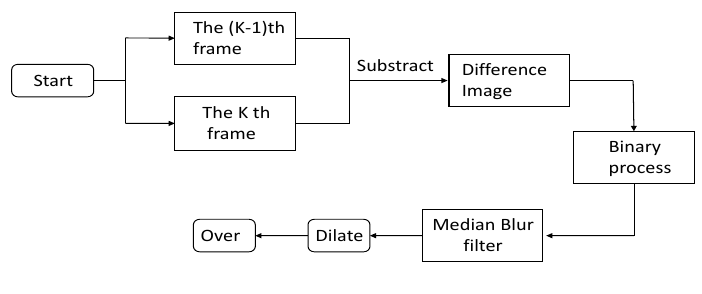
Figure 5. Frame difference